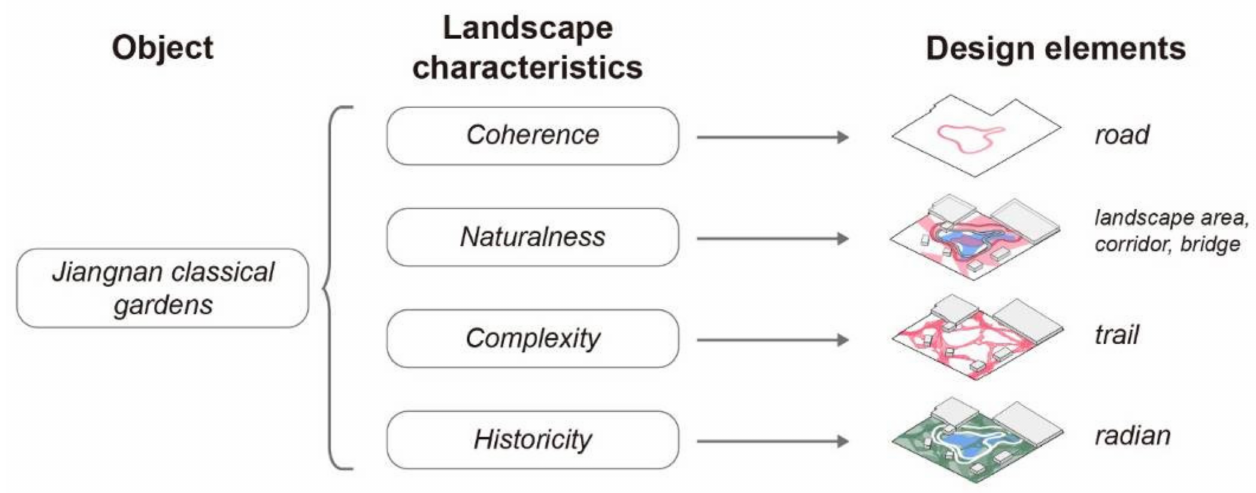
Figure 11. The dimensions of landscape characteristics of Jiangnan classical